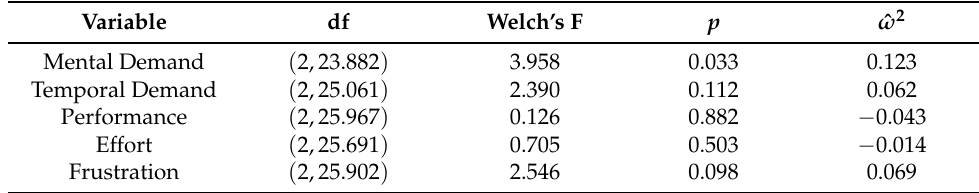
Table 2. Post hoc Welch ANOVA results for NASA-TLX Test.